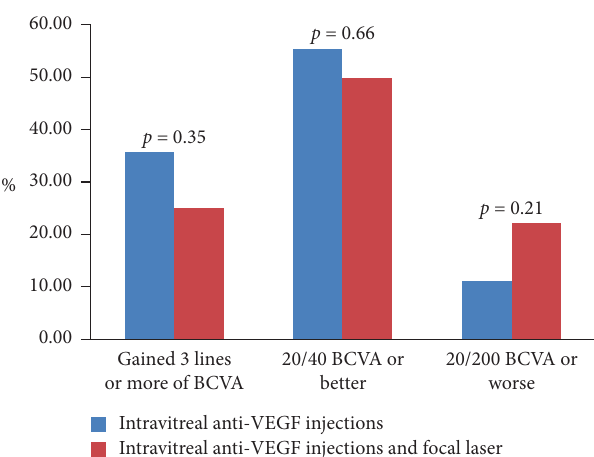
Figure 1: Visual acuity outcome comparison between anti-VEGF injections alone and anti-VEGF injections combined with focal